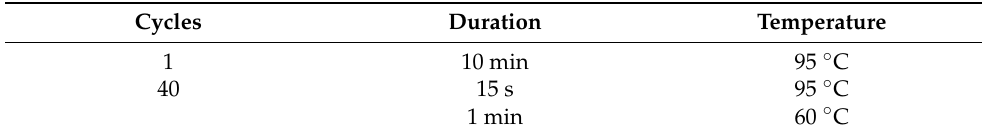
Table 1. PCR cycling